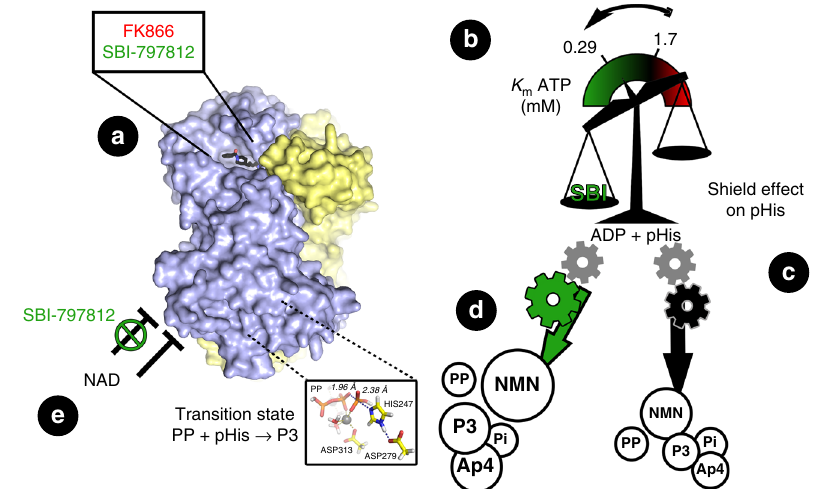
Fig. 7 Proposed SBI-797812 mechanism of action. SBI-797812 (NAMPT activator) and FK-866 (NAMPT inhibitor) have overlapping binding sites at the NAMPT active site ( a ). Binding of SBI-797812 dramatically shifted the reaction equilibrium of the reversible NAMPT reaction to promote NMN production and NAM consumption. ATP was obligatory for NAMPT activation by SBI-797812. SBI-797812 increased the af fi nity of NAMPT for ATP ( b ). SBI-797812 exerted a Water Shield Effect on the phosphorylated i.e., activated) form of NAMPT (pHisNAMPT) ( c ). The pHis247 adduct was more resilient to hydrolysis upon SBI-797812 binding (green gear) such that the PRPP/NAM, ATP and PP substrates can better react with pHisNAMPT. This leads to increased levels of NMN (in the “ complete ” reaction), P3 (in the presence of ATP + PP) or Ap4 (in the presence of ATP) ( d ). The transition state for NAMPT-catalyzed P3 formation is depicted in the insert. Finally, SBI-797812 binding relieved NAD + end product feedback inhibition (in the presence of NMNAT1-3) ( e ). Overall, SBI-797812 transformed NAMPT into a “ super catalyst ” making it possible for substrates to be captured and processed